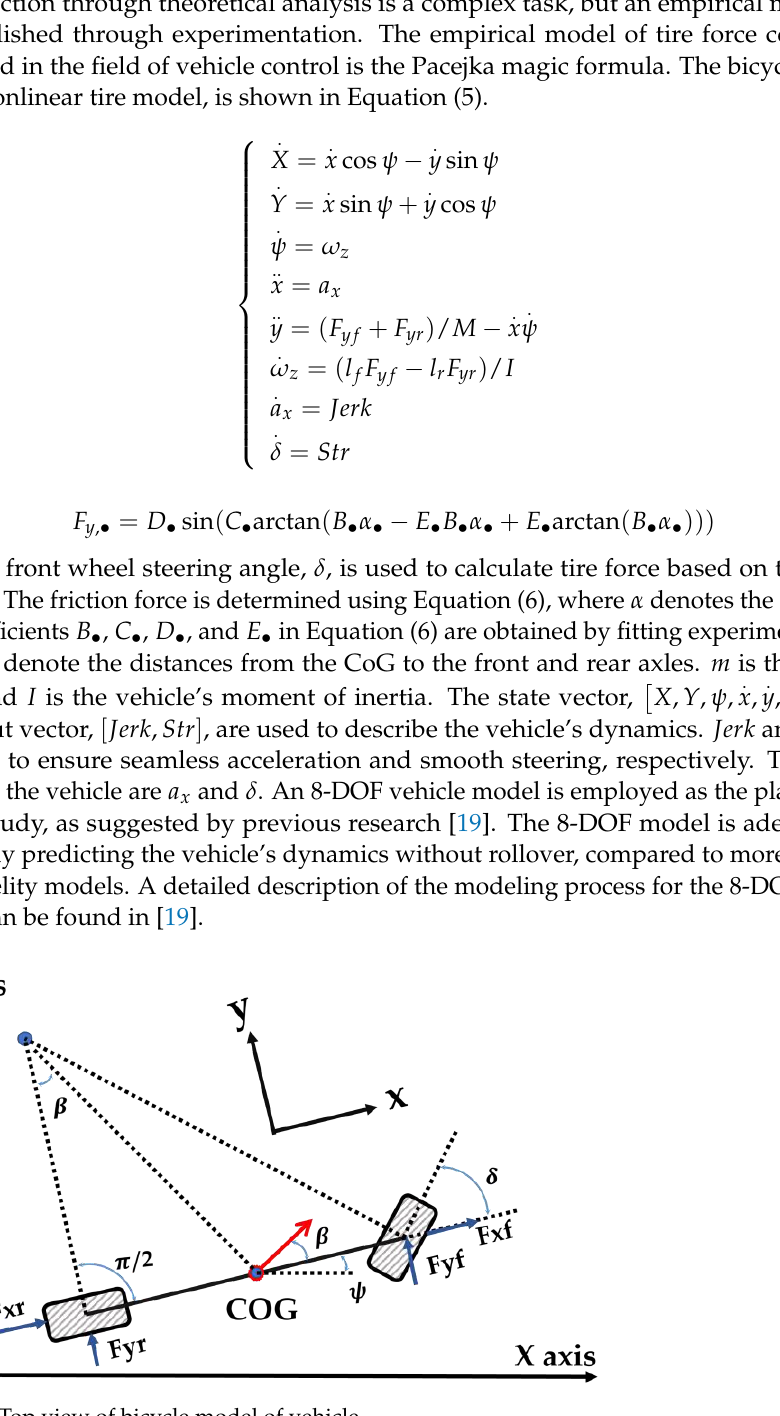
Figure 2. Top view of bicycle model of vehicle.